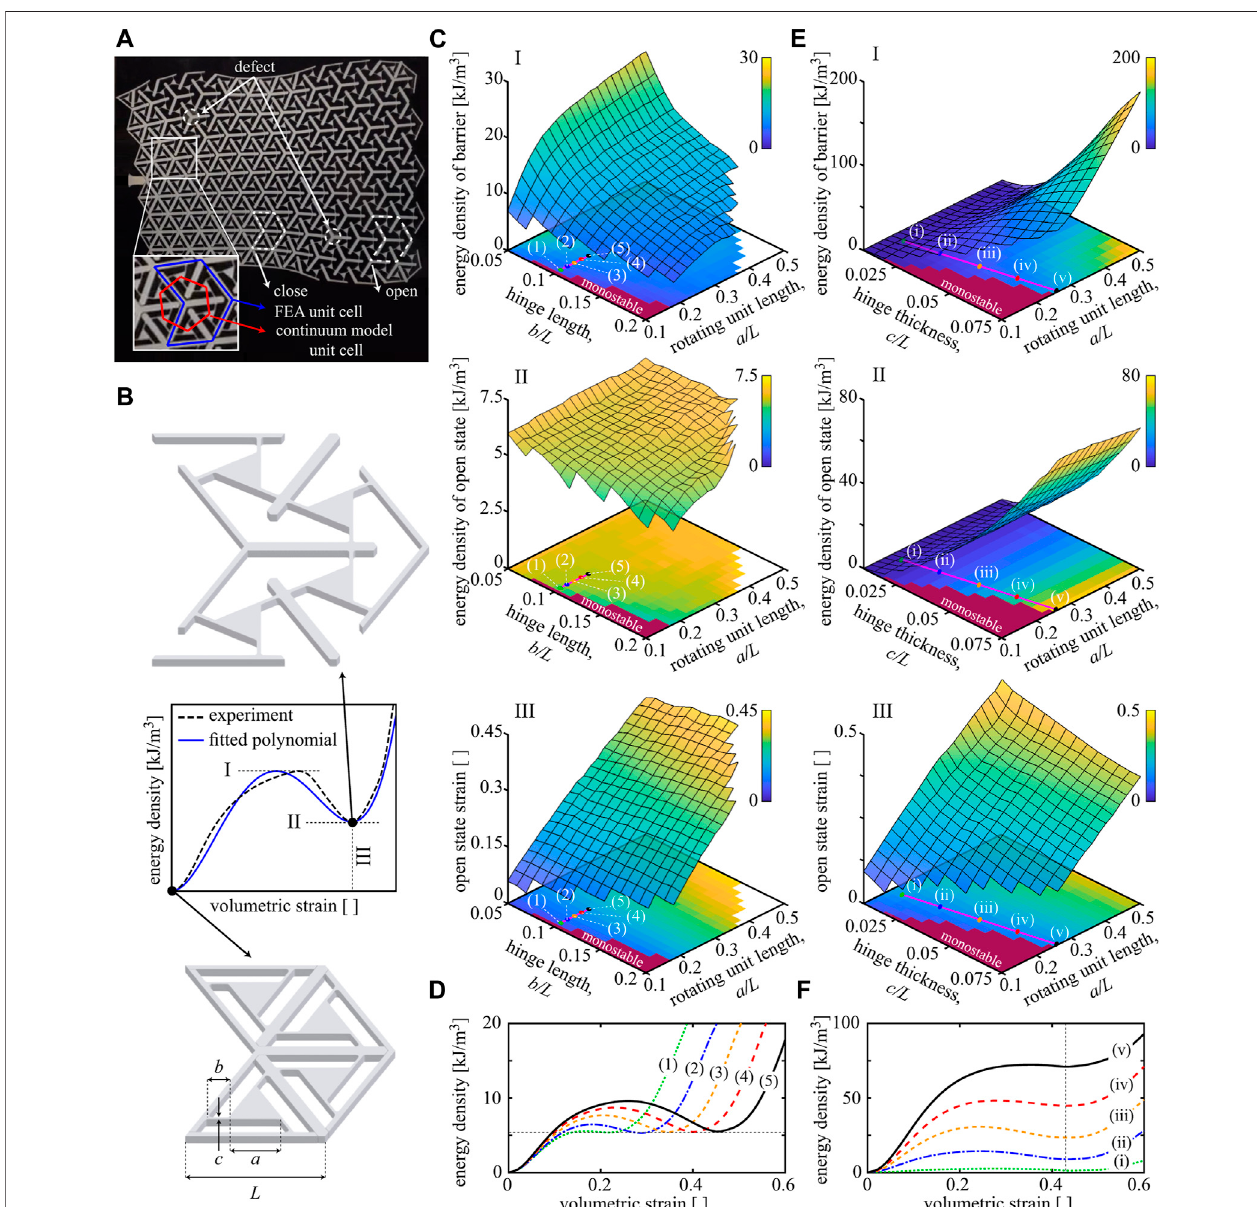
FIGURE 2 | Architectural parameters control the bistability. (A) A 2D defected multistable structure with a gradual transformation of unit cells from their open con fi guration to the closed one. This structure was produced by introducing cuts into a polymer sheet (Jin et al., 2020). (B) When a single unit cell under volumetric strainingisbistable,thestrainenergydensityexhibitstwostableminimaassociatedwiththeclosed( ε 0 )andopen( ε s )con fi gurations. Theenergydensityisapproximated by a fourth-order polynomial characterized by the energy density barrier (I), the energy density of the open state (II), and the open-state strain (III). The unit cell ’ s architecture is characterized by the unit cell length L , rotating unit length a , hinge length b , and thickness c . (C) Design maps of strain energy characteristics for varying hingeandrotatingunitlengthswhilekeepingthehingethicknessconstantat c (cid:1) 0 . 025 L . (D) Double-wellstrainenergydensitiescorrespondingtothecoloredmarkersin the design maps of Figure 2C . (E) Design maps of bistability characteristics for varying hinge thicknesses while keeping the hinge length constant at b (cid:1) 0 . 1 L . (F) Double-well strain energy densities corresponding to the markers in the design maps of Figure 2E .